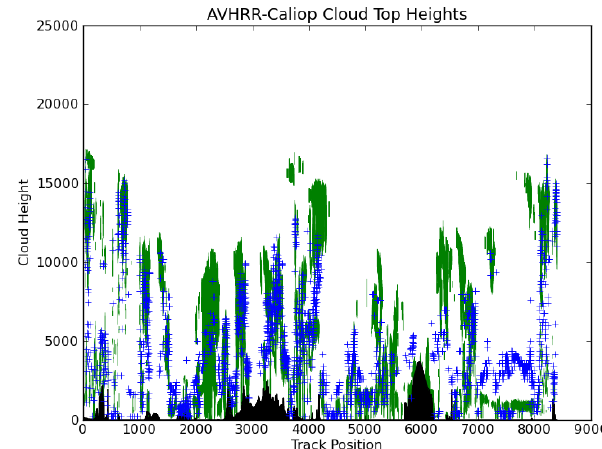
Fig. 3. Matched CALIPSO-CALIOP cloud mask (green) and NOAA-AVHRR cloud top height values (blue, in metres) from CLARA-A1/PPS for the same global orbit as shown in Fig. 2. Track position is given in number of AVHRR GAC pixels (to be multiplied by 4 to get roughly the distance in km). Significant topographic fea- tures are seen in black at track positions 6000 (Antarctica) and 3000 (Russia/China).